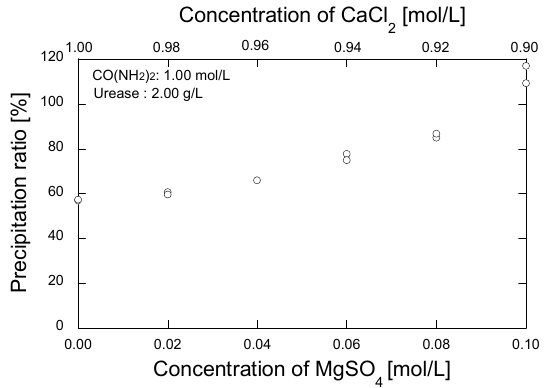
Figure 4. Precipitated mass in various concentrations of MgSO 4 -CaCl 2.